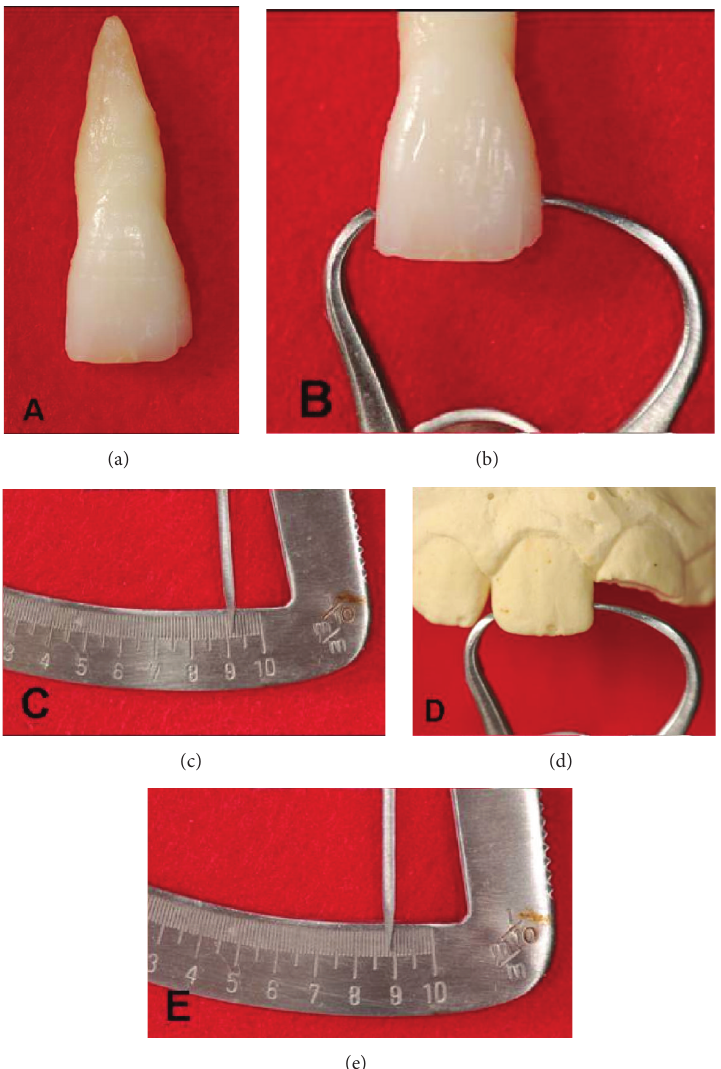
Figure 3: (a) Selected extracted central incisor. (b), (c) Mesiodistal measurement of the extracted tooth. (d), (e) Mesiodistal measurement of the remaining tooth in the